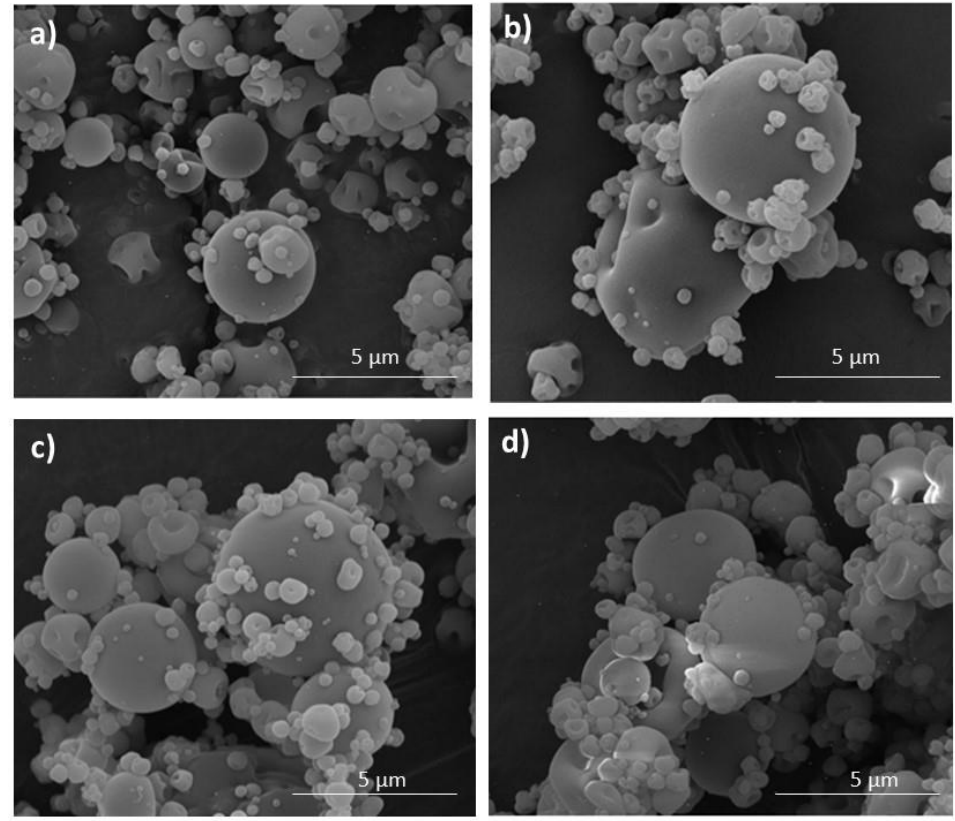
Figure 4. Representative images of microparticles formulation F1 ( a ), F4 ( b ), FL1 ( c ), and FL4 ( d ) under magnification 20,000 ×